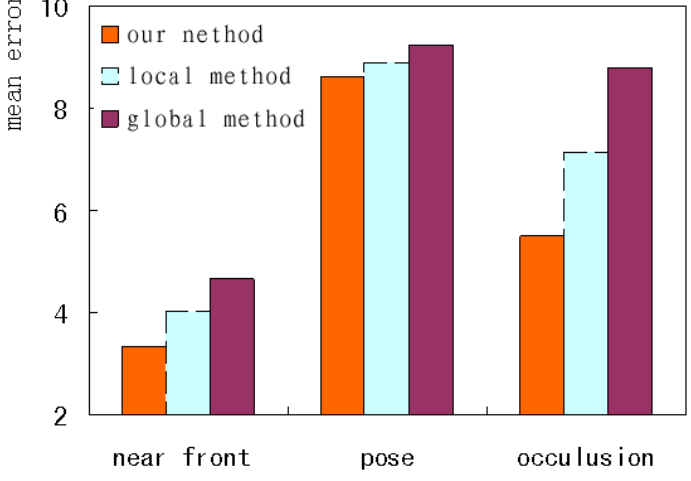
Figure 17. The error comparison under the different conditions.